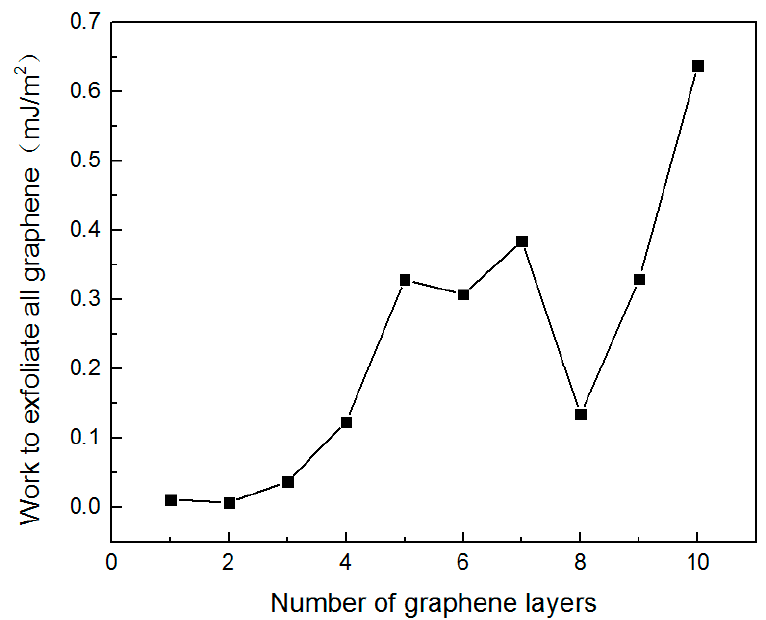
Figure 14. The maximum Fz to exfoliate all layers.